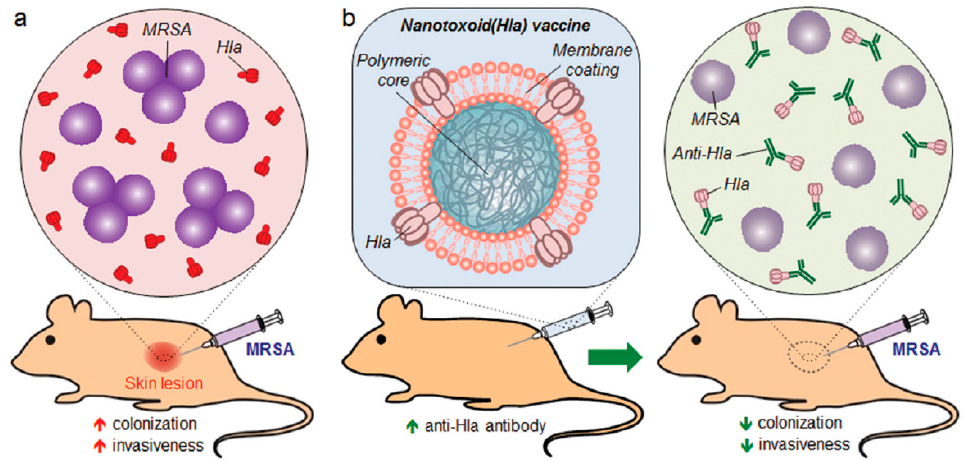
Figure3. Schemeofbiomimeticnanotoxoidshowingprotectionagainstmethicillin-resistant Staphylococcus Figure 3. Scheme of biomimetic nanotoxoid showing protection against methicillin-resistant aureus (MRSA)-induced skin infection. a ) The normal condition of skin lesion formation in which MRSA Staphylococcus aureus (MRSA)-induced skin infection. a ) The normal condition of skin lesion bacteria employs hemolysin (Hla) and helps in colonizing the site. b ) After nanotoxoid vaccination, formation in which MRSA bacteria employs hemolysin (Hla) and helps in colonizing the site. b ) After anti-Hla and neutralize the toxins produced by MRSA. Reproduced with permissions from Ref. [20], nanotoxoid vaccination, anti-Hla and neutralize the toxins produced by MRSA. Reproduced with Copyright © 2016, John Wiley and permissions from Ref. [20], Copyright © 2016, John Wiley and sons.